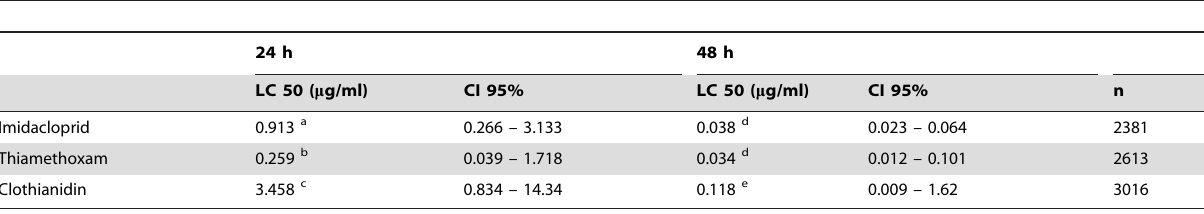
Table 4. Neonicotinoid toxicity in the pea aphid on first-instar larvae for 24 h and 48 h of insecticide exposure using an artificial diet